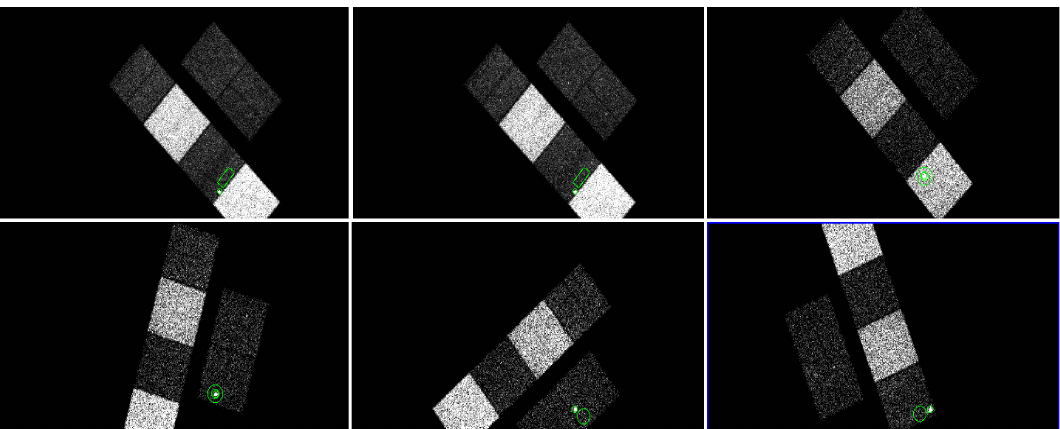
Figure 1. TV Cassiopeia (TV Cas) with the Chandra observations in the order of: 07082, 08458, 11080, 11081, 11082, and 11084. For observation ID 11080 and 11081, the smallest inner circle in green is the source region of TV Cas, and the outer annulus is the background extraction region. Similar to the other 4 observations, just the background region is the big green